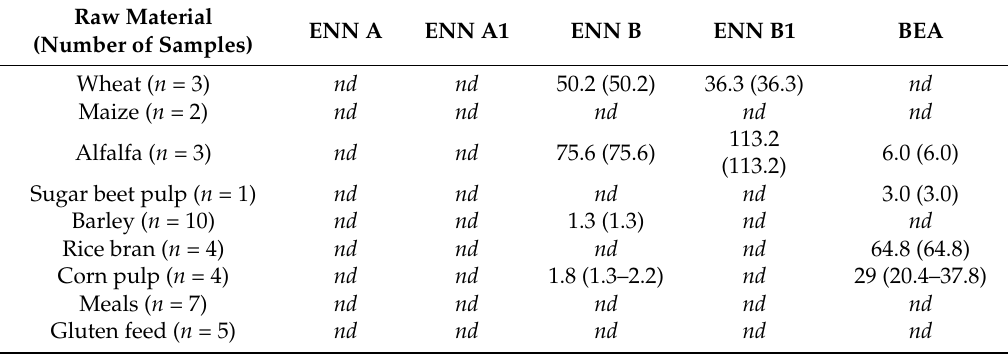
Table 3. The Enniatin and Beauvericin contents in the raw materials analyzed ( n = 39). The results are expressed as an average (Concentration Range) in µ